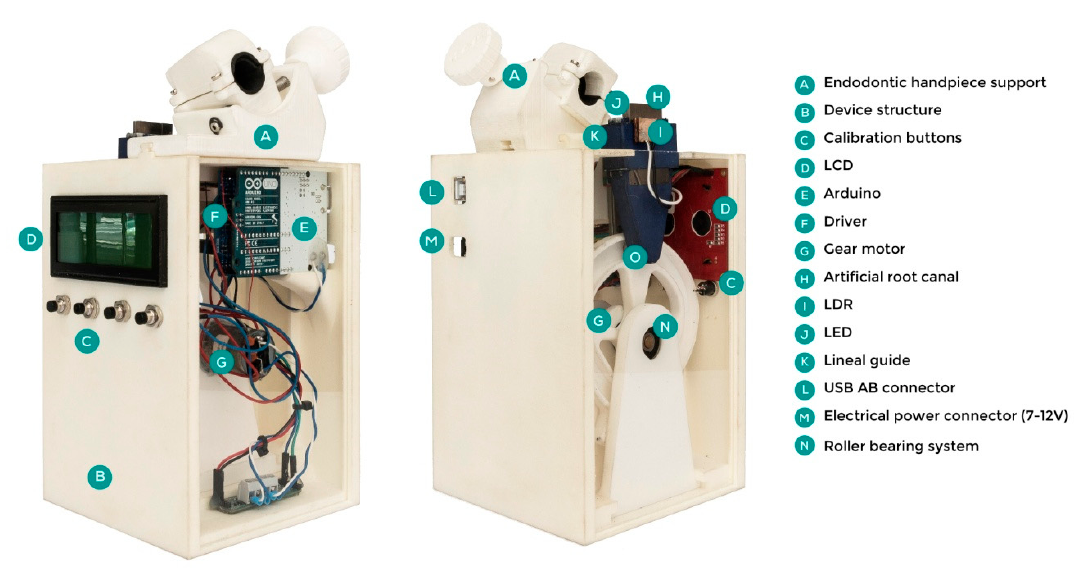
Figure 1. Parts of the hardware of the cyclic fatigue test device.